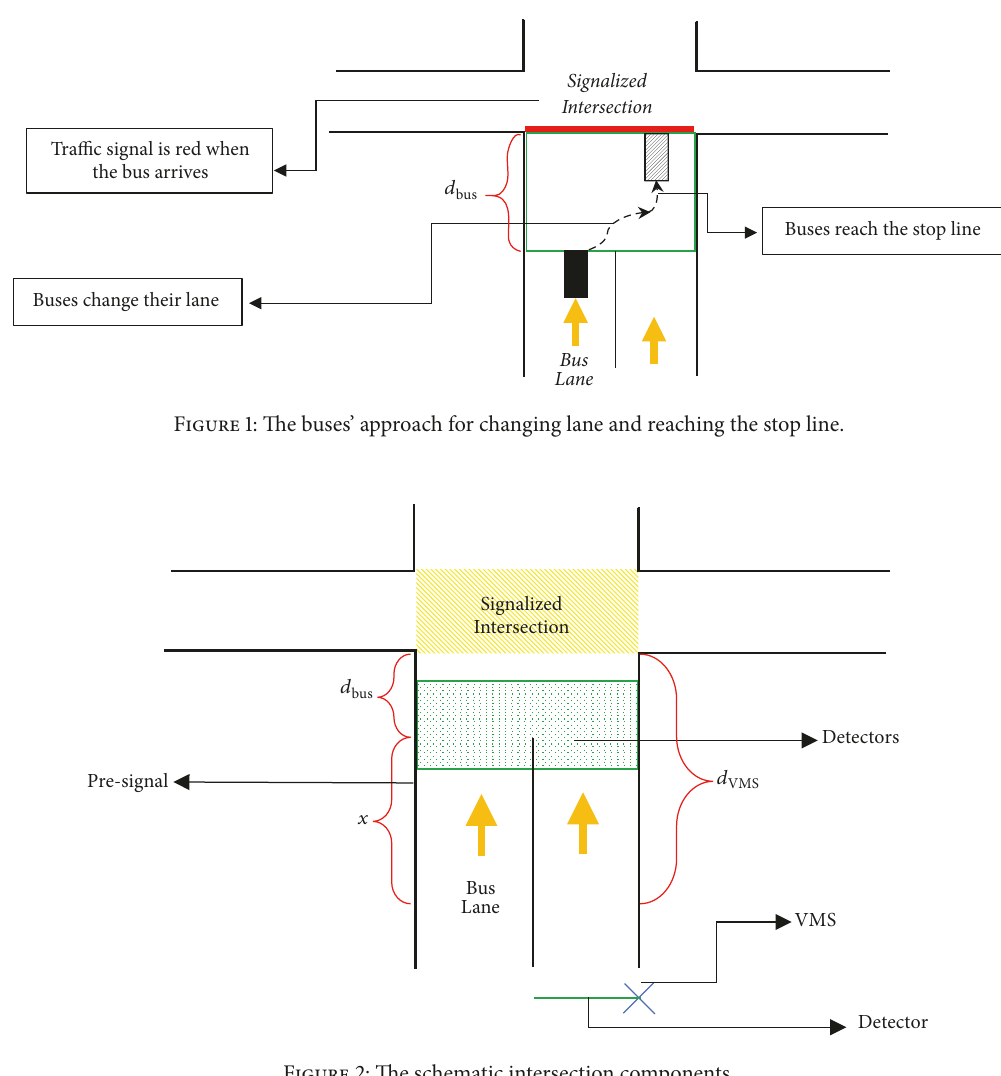
Figure 2: The schematic intersection